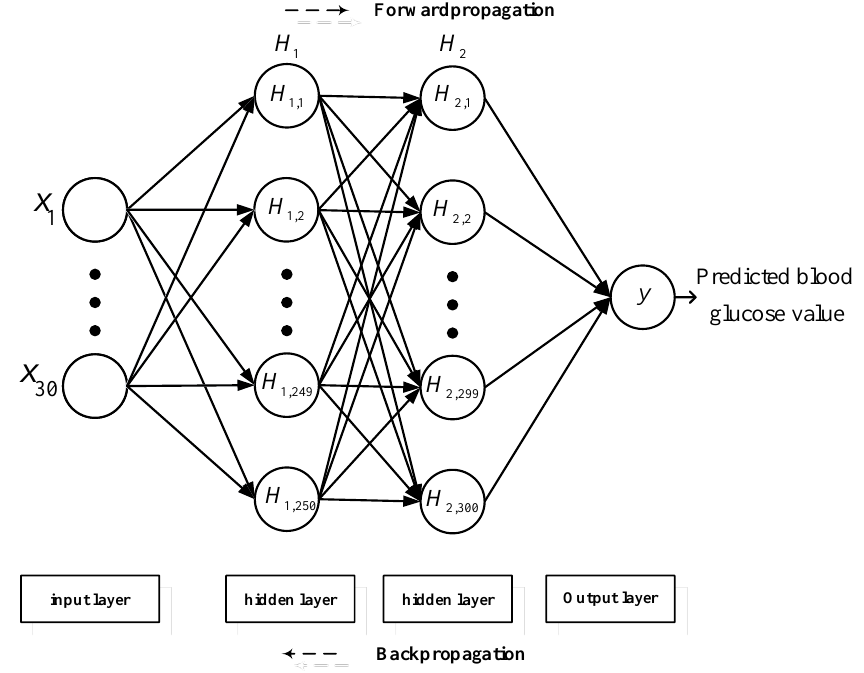
Figure 5. Proposed BPNN architecture. Table 2. Input characteristic values used by the